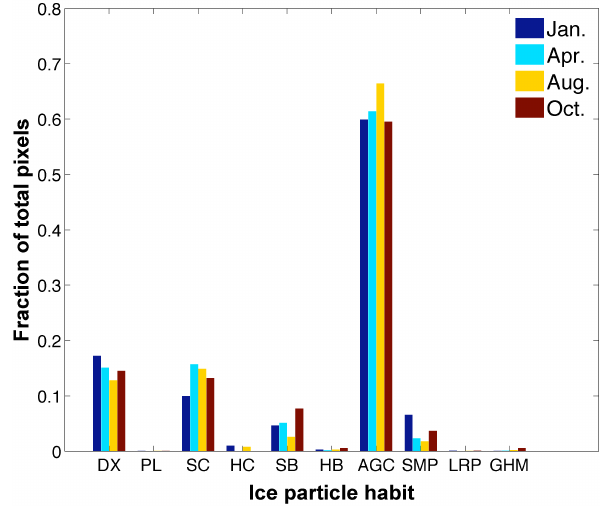
Fig. 6. The ice roughness inferred from global data over ocean from four different months, shown as the fraction of total pixels assigned one of the 17 values of roughness considered in the retrieval process. The roughness parameter ranges from 0 (smooth) to 0.8 (extremely